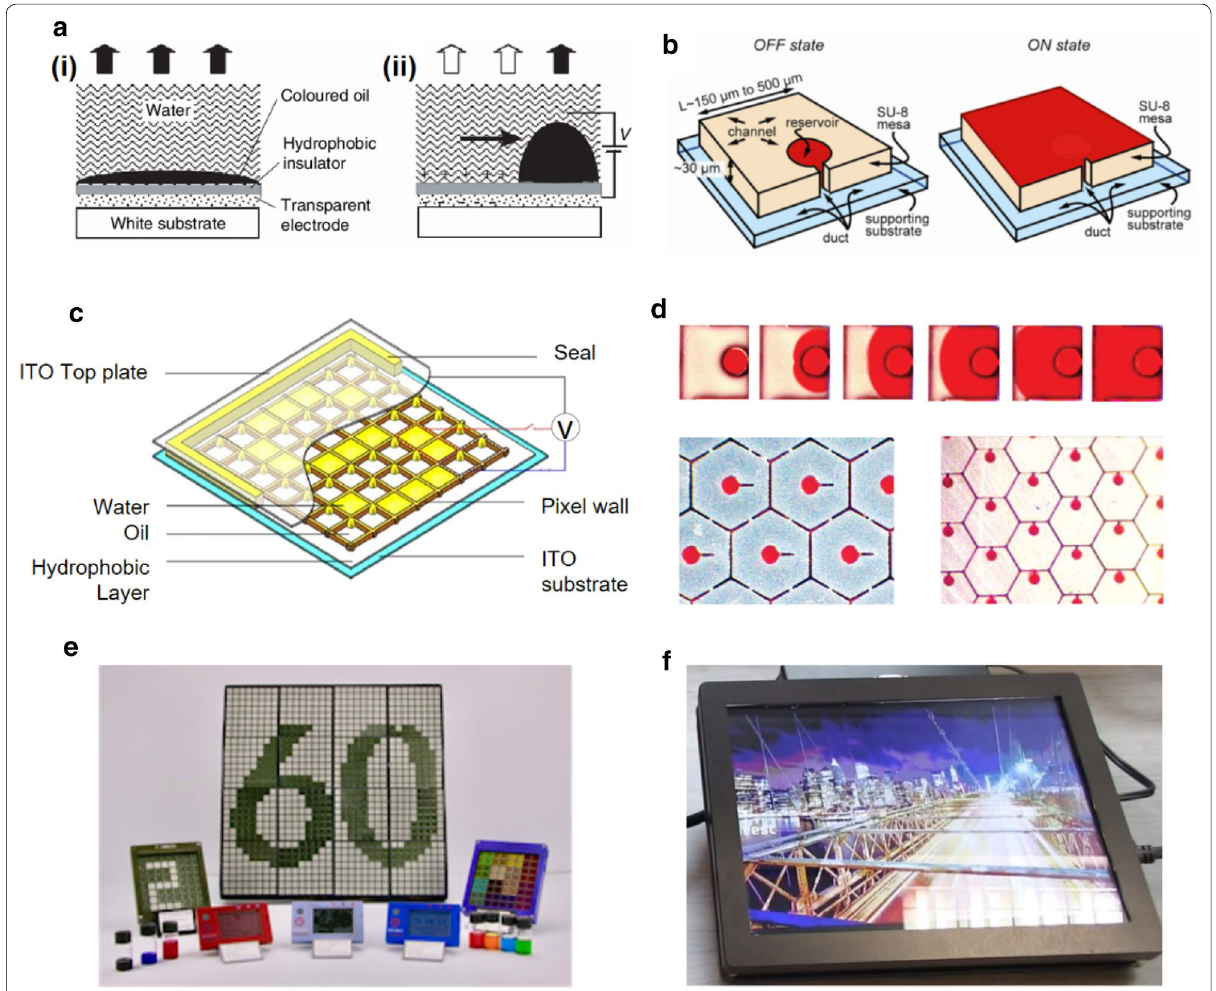
Fig. 3 Technologies for electrowetting and electrofluidic display. a Structure and principle of electrowetting display. (i) Without any applied voltages, a colored oil film covers the pixel. (ii) When a voltage (~ 10 V) is applied, the oil film is contracting and makes the pixel transparent. b Schematic of an electrofluidic cell without a top plate. c Pixel array of electrowetting display with yellow dye based on alkylated